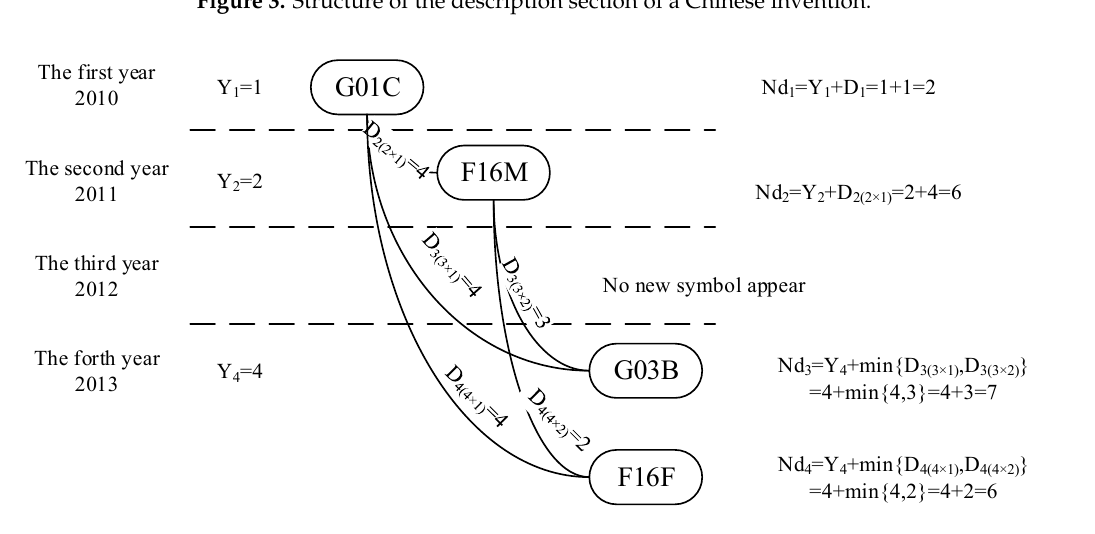
Figure 3. Structure of the description section of a Chinese invention.